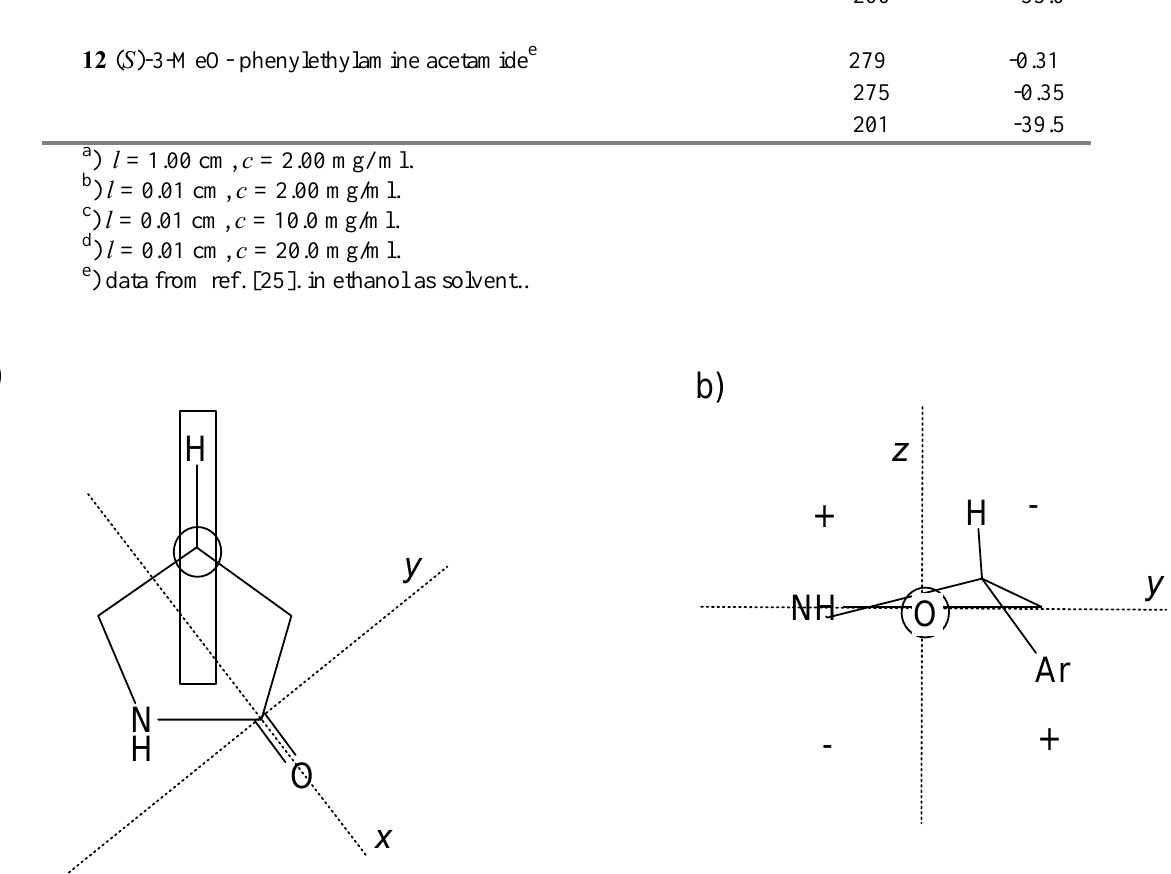
Figure 3. Application of the lactam octant rule. a) the xy -plane is defined by the N-(1)-C(2)-O plane, z- axis coming out of the plane. Rotating structure around the y -axis, and viewing the molecule down the x -axis results in the projection shown in b). In this case all the substituents are in the quadrants behind the yz-plane. The aromatic moiety falls on the lower right quadrant, therefore the sign of the CE associated with the n- p* transition at 220 nm in ( R )-rolipram is expected to be